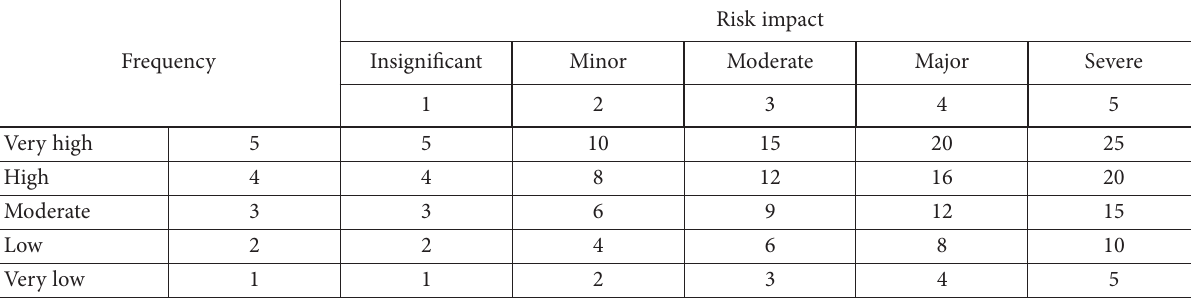
Table 1. Risk matrix (Department of Occupational Safety and Health [DOSH],